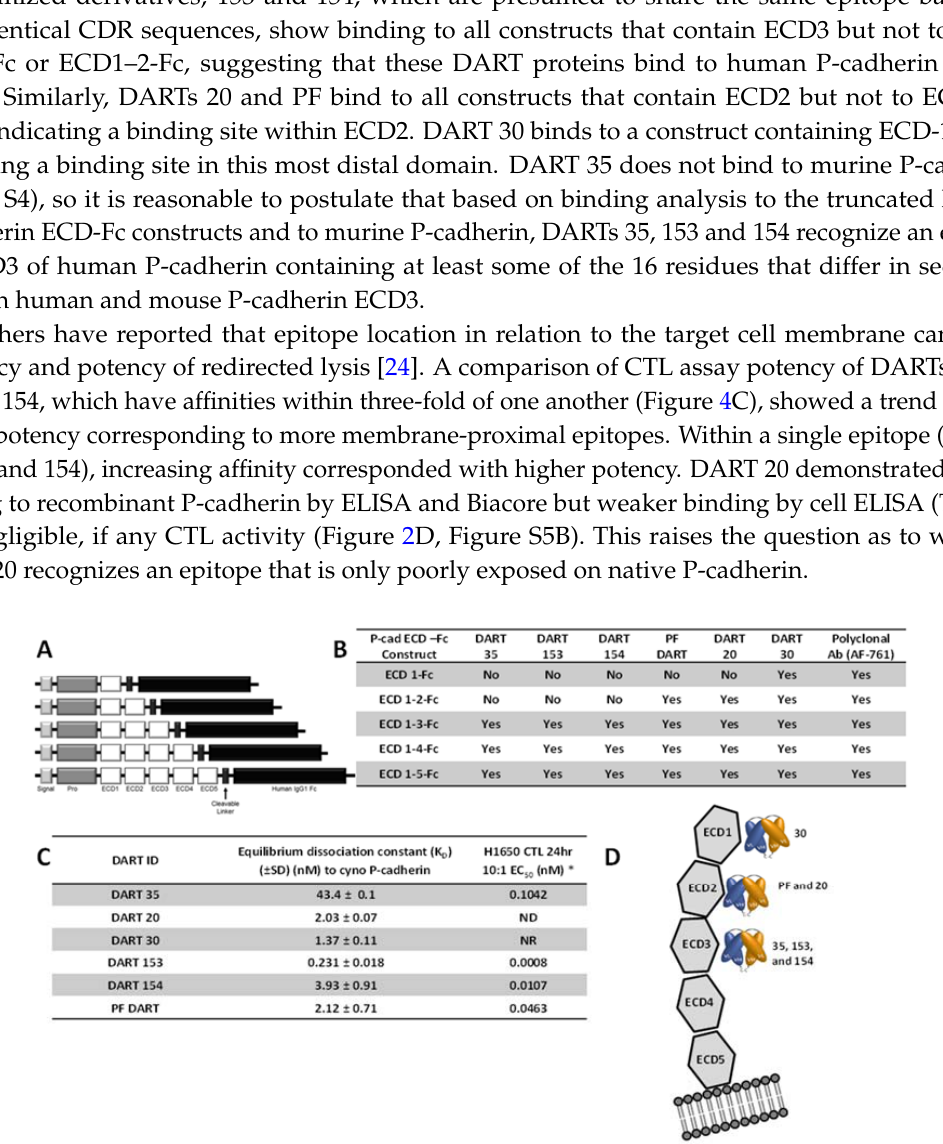
Figure 4. Epitope mapping of DARTs to the recombinant human P ‐ cadherin extracellular domain. ( A ) Schematic representation of truncated human P ‐ cadherin ECD constructs generated for epitope mapping studies. Gray shading represents the pro ‐ peptide domain; White represents the P ‐ cadherin ECD; Black shading represents the human IgG1 Fc with cleavable linker. ( B ) Summary of binding